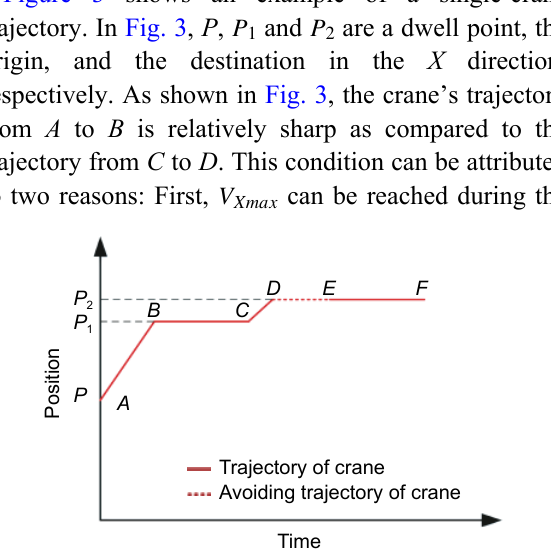
Fig. 3 Example of trajectory of one crane with idle